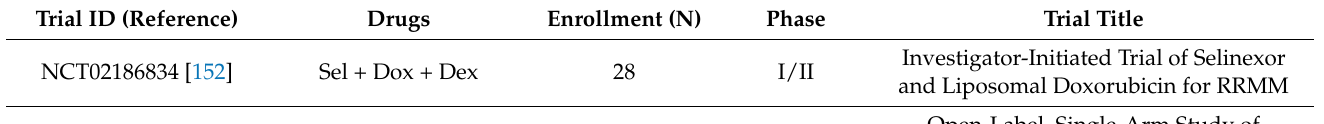
Table 6. Selected Clinical Trials of Selinexor in